Question: Write a caption explaining this figure to a reader.
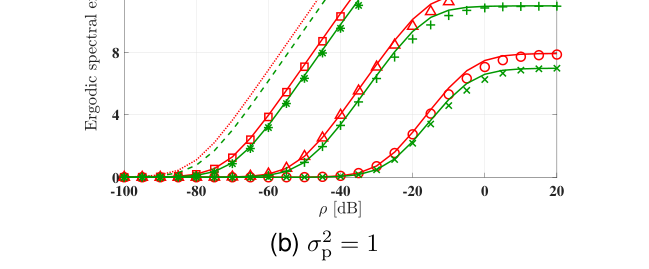
Answer: Theoretical analysis (33), (34) and simulation results of the ergodic achievable rate R versus the transmit power ρ for different number of RHS elements, with imperfect RHS phase shift design, i.e. σ2 p > 0.